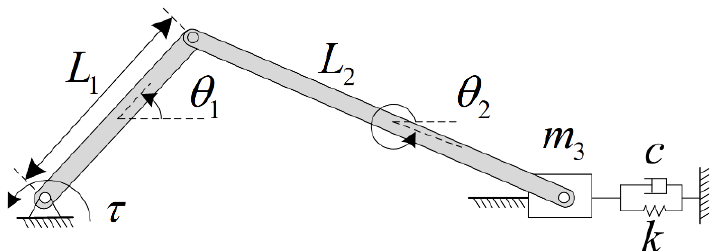
Figure 2. Schematic of a crank slider mechanism. Table 1. Parameters of the crank slider mechanism.